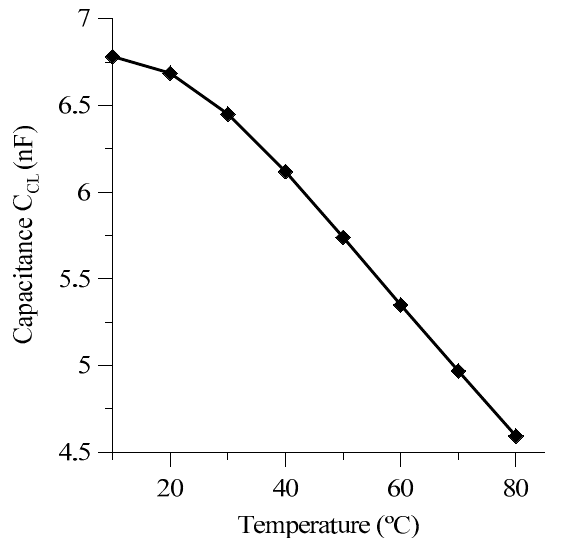
Figure 5. Variation of NLC cell capacitance as a function of temperature at a frequency of 10 kHz.